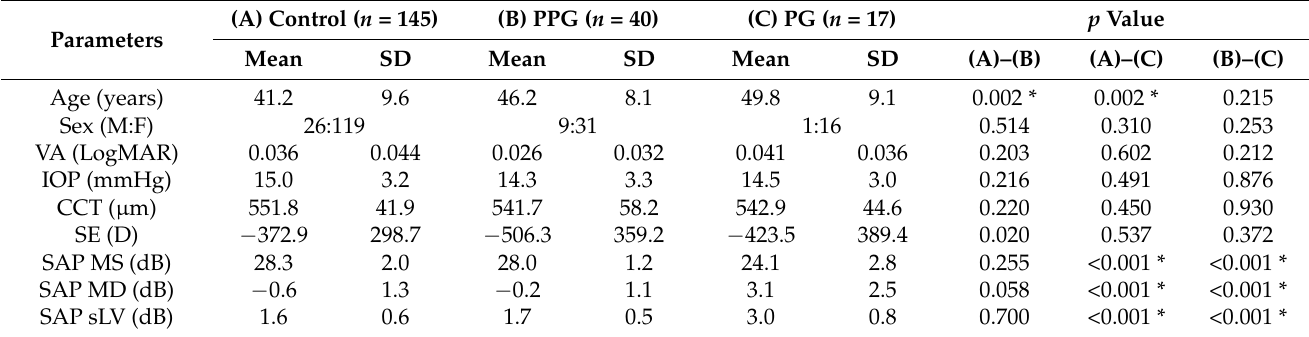
Table 1. Demographics of the subjects of control and study groups.